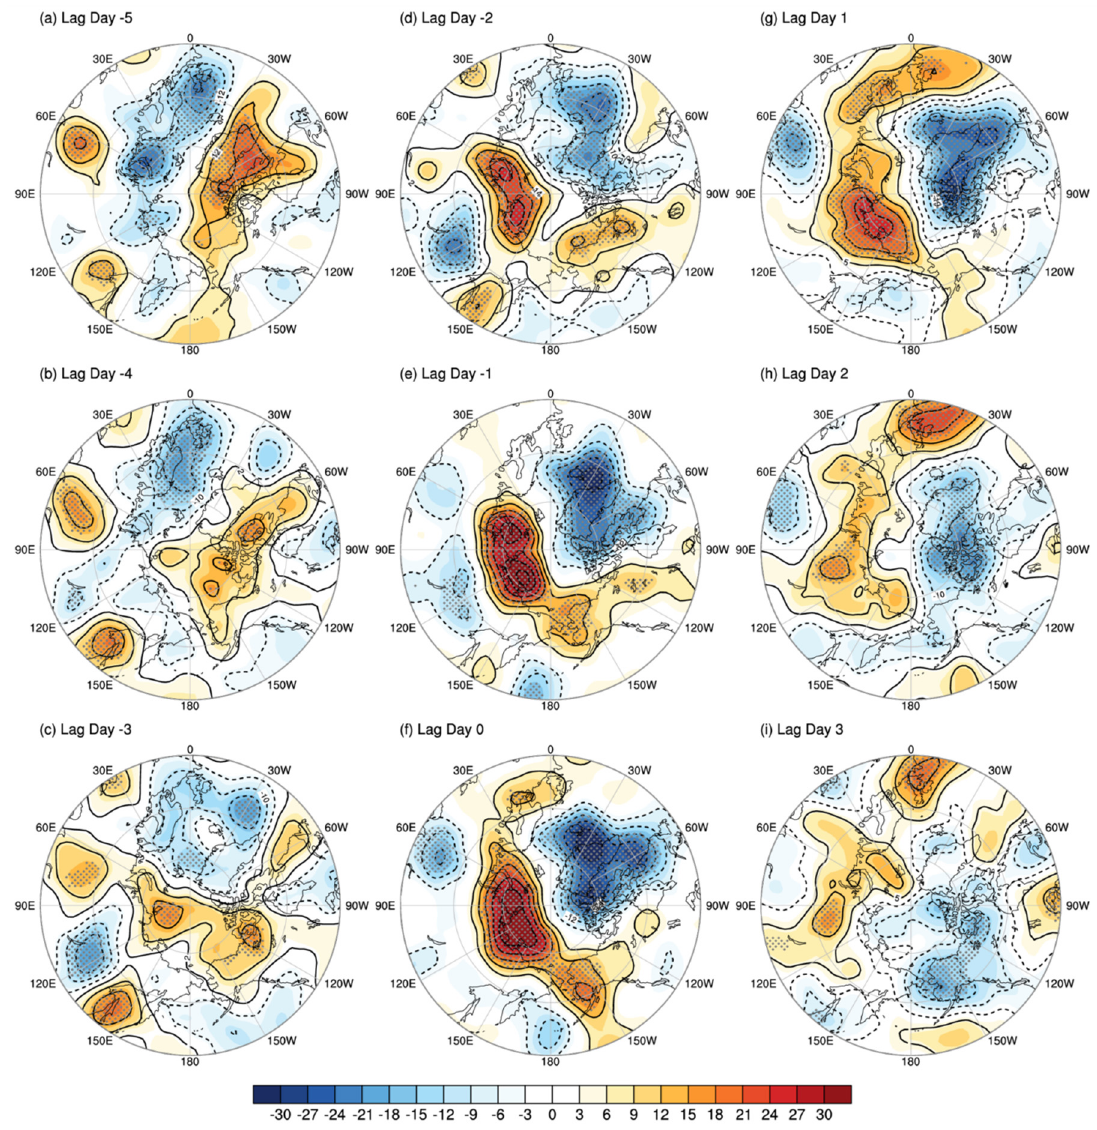
Figure 6. Composite daily evolutions in the synoptic-scale 500-hPa geopotential height (H500) anomalies (gpm) from − 5 to +3 days ( a – i ) for 112 best-matching events of SOM2. The dots denote the grids, where the anomalies were statistically significant at a 5% level as per the two-sided Student’s t -test.